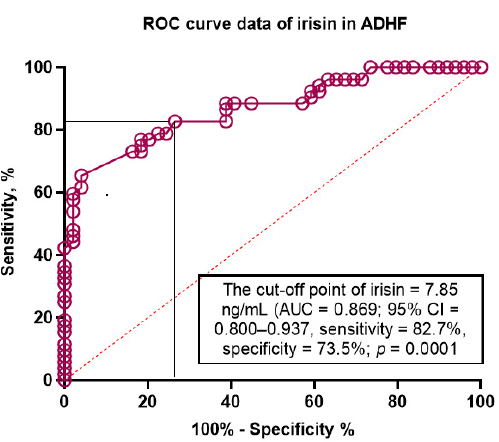
Figure 2. The predictive model for ADHF based on the serum levels of irisin. The results of the ROC curve analysis. Abbreviations: AUC, area under curve; CI, confidence interval. Table 3. Predictors for ADHF in T2DM patients with chronic HF. The results of the univariate and multivariate log regression